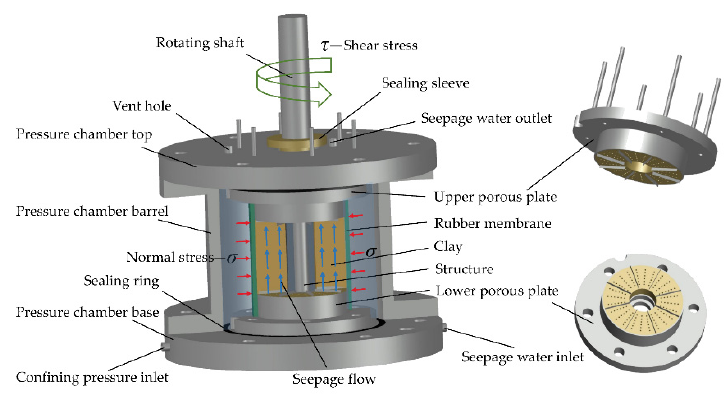
Figure 3. Three-dimensional schematic diagram of the shear-seepage pressure chamber.